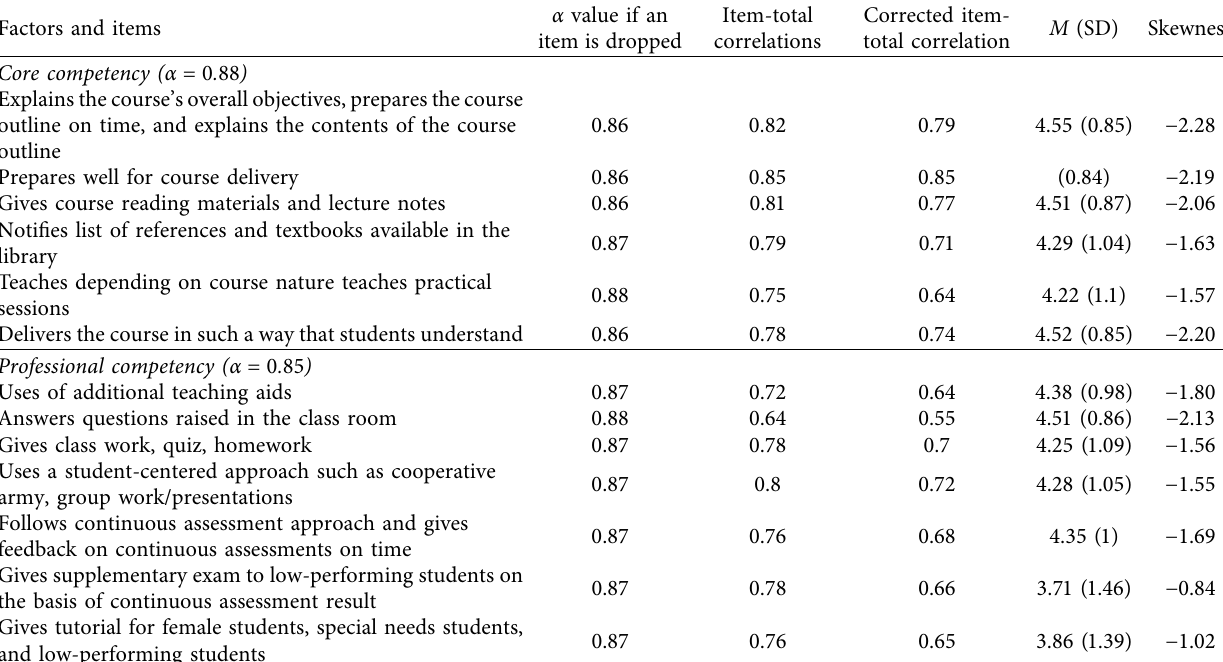
α value if an Item-total Corrected item- M (SD) item is dropped correlations total correlation